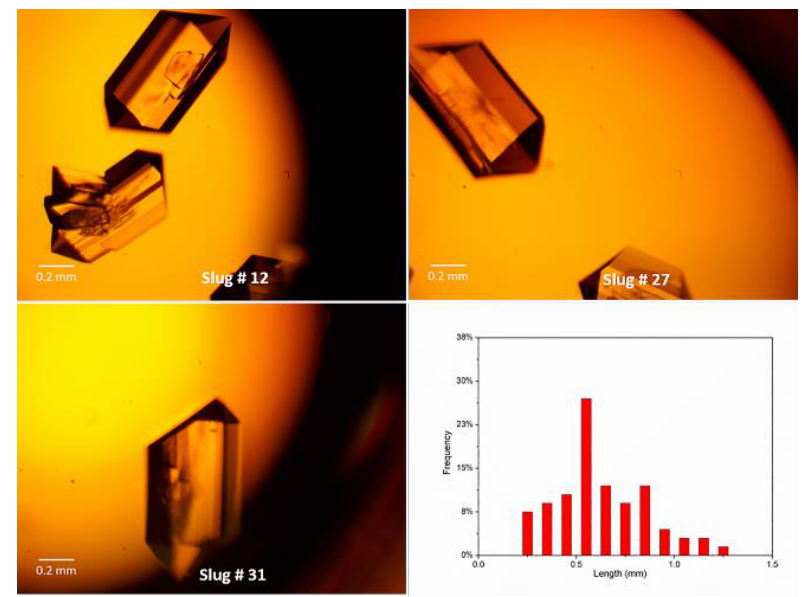
Figure 4. Representative off-line microscope images (with polarizer) of produced crystals in slugs with an aspect ratio of about 1.2 and the crystal size distribution from all off-line images. Experimental details are in Table 1, Condition 2. Scale bar: 0.2 mm.